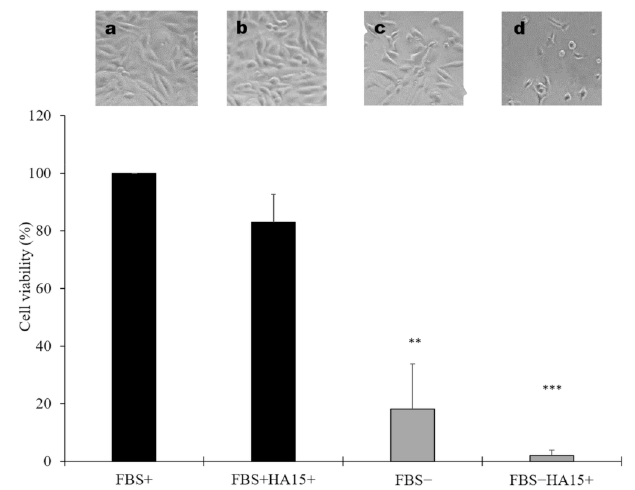
Figure 7. Viability of A375 cells under different cell culture conditions. Before drug treatment, cells were cultured without FBS for 14 h. Then, the cells were treated with 10 µ M of HA15 with (FBS+HA15+) or without FBS (FBS − HA15+) for 48 h and the cell viability was determined. Images above the columns show the morphological changes in A375 melanoma cells under different cell culture conditions: ( a ) FBS+: cells grown in complete medium; ( b ) FBS+HA15+ complete medium and 10 µ M of HA15; ( c ) FBS– cells grown without FBS; ( d ) FBS − HA15+-starved cells treated with 10 µ M of HA15. Data are presented as the mean ± SD of three independent experiments. Significant differences are indicated by asterisks (** p < 0.01; *** p < 0.001).